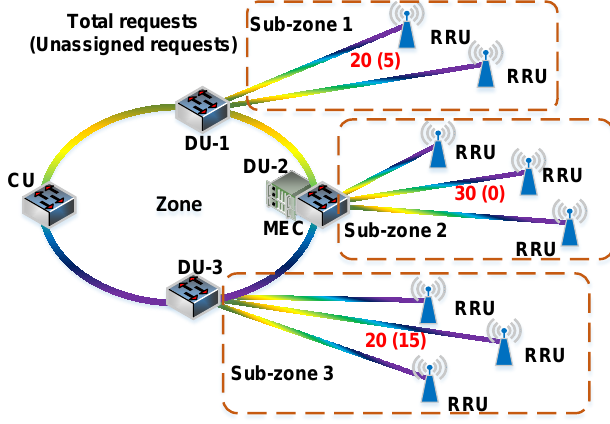
Figure 3. An example of determining the deployment location.